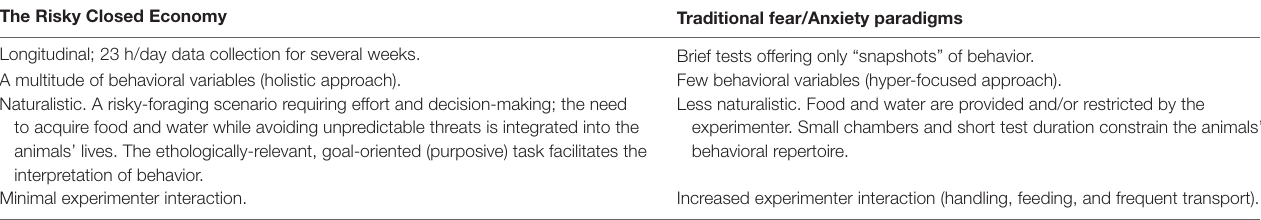
interpretation of